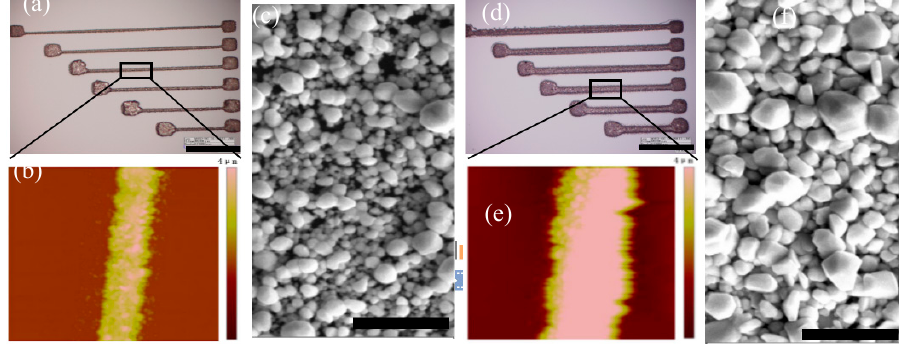
Figure 4. Optical, AFM, and SEM images of the Ag electrodes deposited at different time intervals. ( a , d ) Optical images of Ag electrodes deposited with in 10 and 20 s, respectively. Both the bars represent 100 µ m; ( b , e ) magnified AFM images of the black square-enclosed regions in panels a and d, respectively. Both the scale bars represent 4 µ m. Scan size: 30 µ m × 30 µ m; ( c , f ) topographic images of the surfaces of the Ag electrodes obtained via SEM. Both the bars represent 3 µ